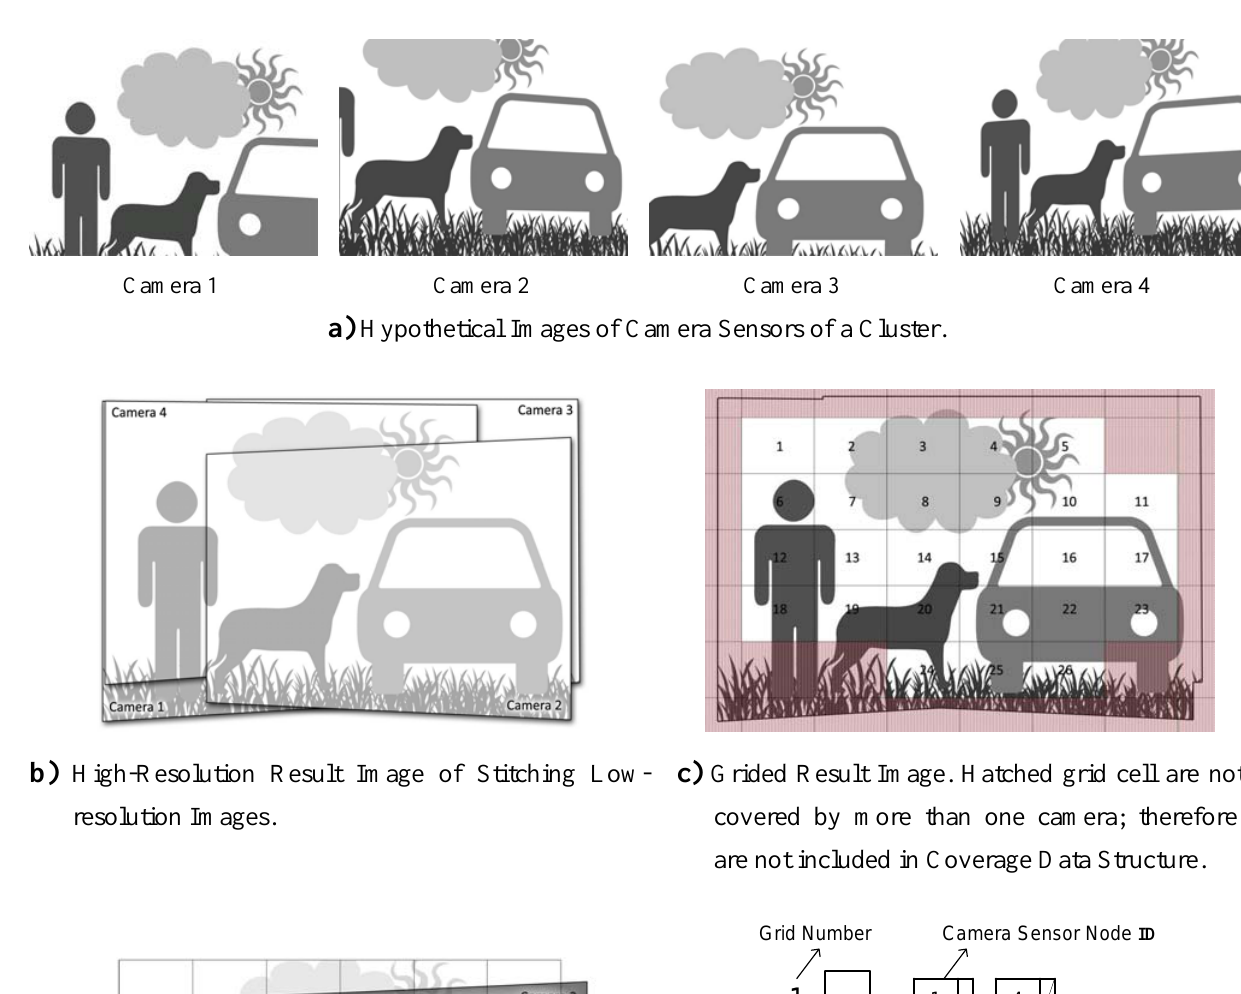
Figure 5. Creating coverage data